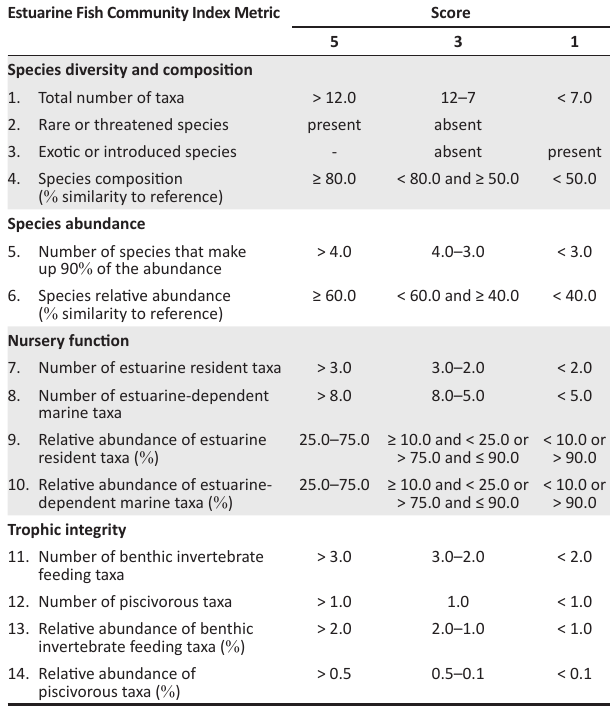
TABLE 1: Metric scoring criteria for small closed estuaries in the warm-temperate biogeographic region. Estuarine Fish Community Index